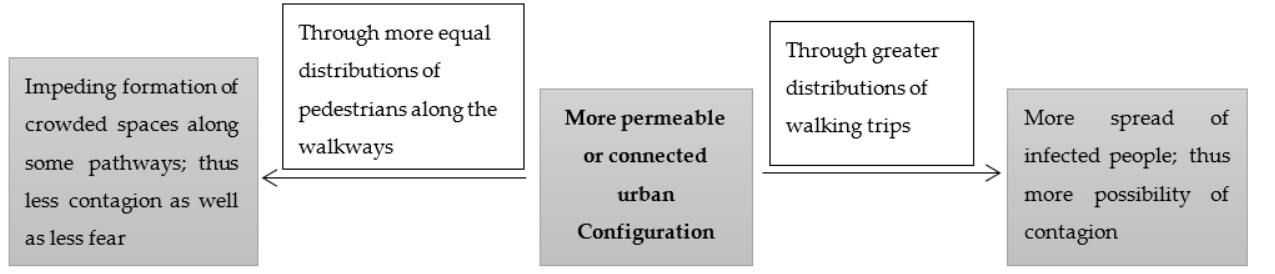
Figure 4. The process of the role of type of urban configuration on the level of contagion as well as stress.